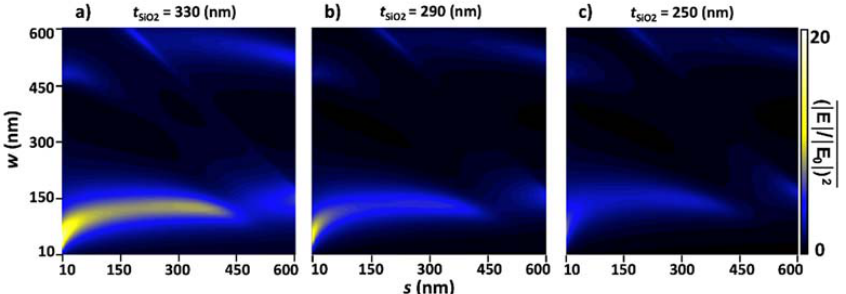
Figure 4. Color plot of line average enhancement versus s and w at three t SiO ₂ values. ( a ) Maximized enhancement at t SiO2 = 330 nm, ( b ) median at t SiO ₂ = 290 nm, and ( c ) minimized at t SiO ₂ = 250 nm.